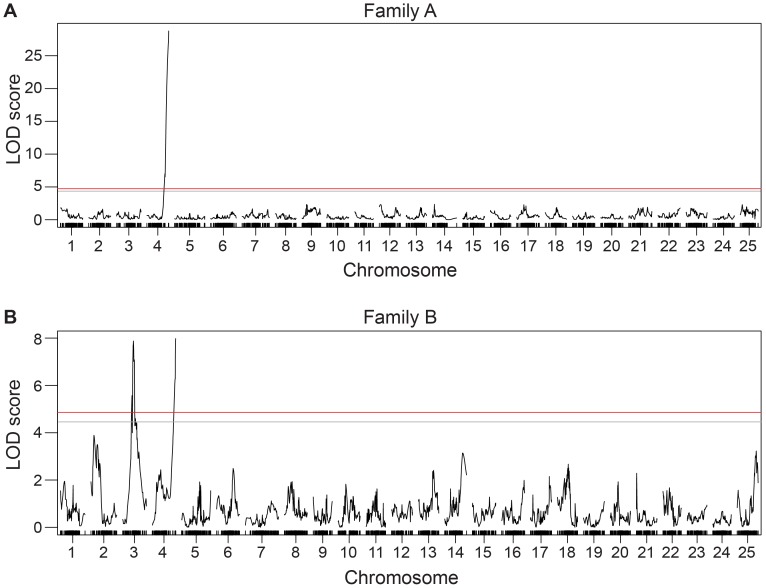
Mapping results for the F2 of reciprocal crosses between *AB and NA wild type stocks.(A) Family A, *AB grandsire. (B) Family B, NA grandsire. Sex is associated with a locus on chr-4 in both families, and a locus on chr-3 in Family B. LOD scores are plotted in order of marker position in cM. Significance thresholds were determined by permutation testing and are indicated by horizontal lines (red = 5%, gray = 10%).